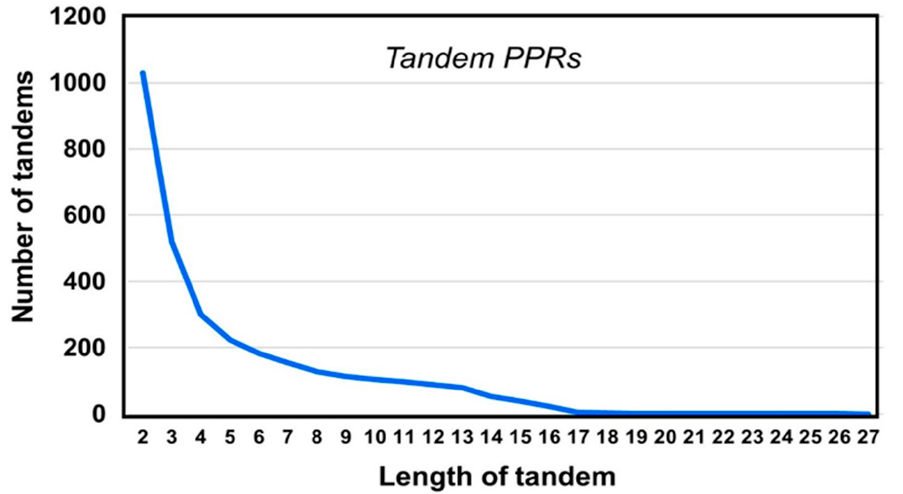
Figure 4. Arrangements of PPR. The graph presents the relative abundance of PPR clusters of different lengths. For example, 3 in the X -axis means a cluster of three tandem PPR units connected without any spacer amino acid between them, i.e., PPR-PPR-PPR. As seen in the graph, the PPR-PPR-PPR triplet was found 519 times in our collection of 2130 non-redundant PPR-containing proteins (details in Section 2.2).